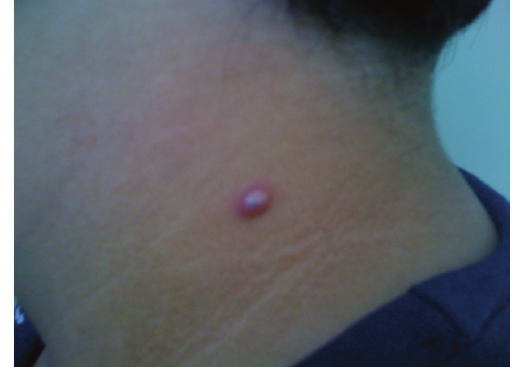
Figure 2: Detail of the lesion: observe the nonexudative papule.